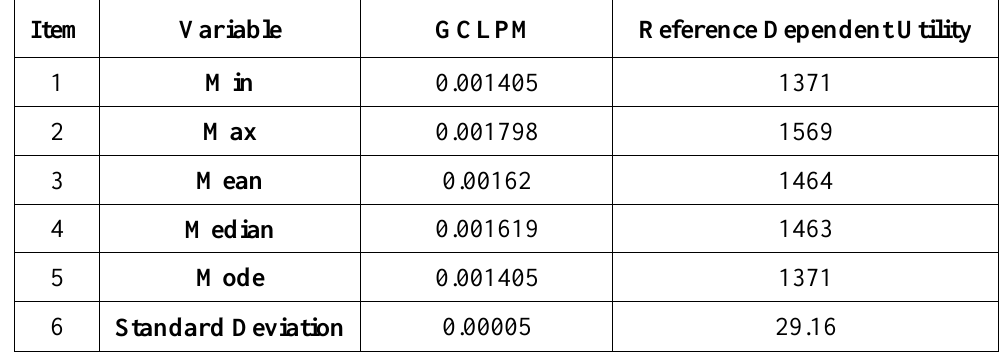
Table 11. Result Specification of Scenario 3 in Third